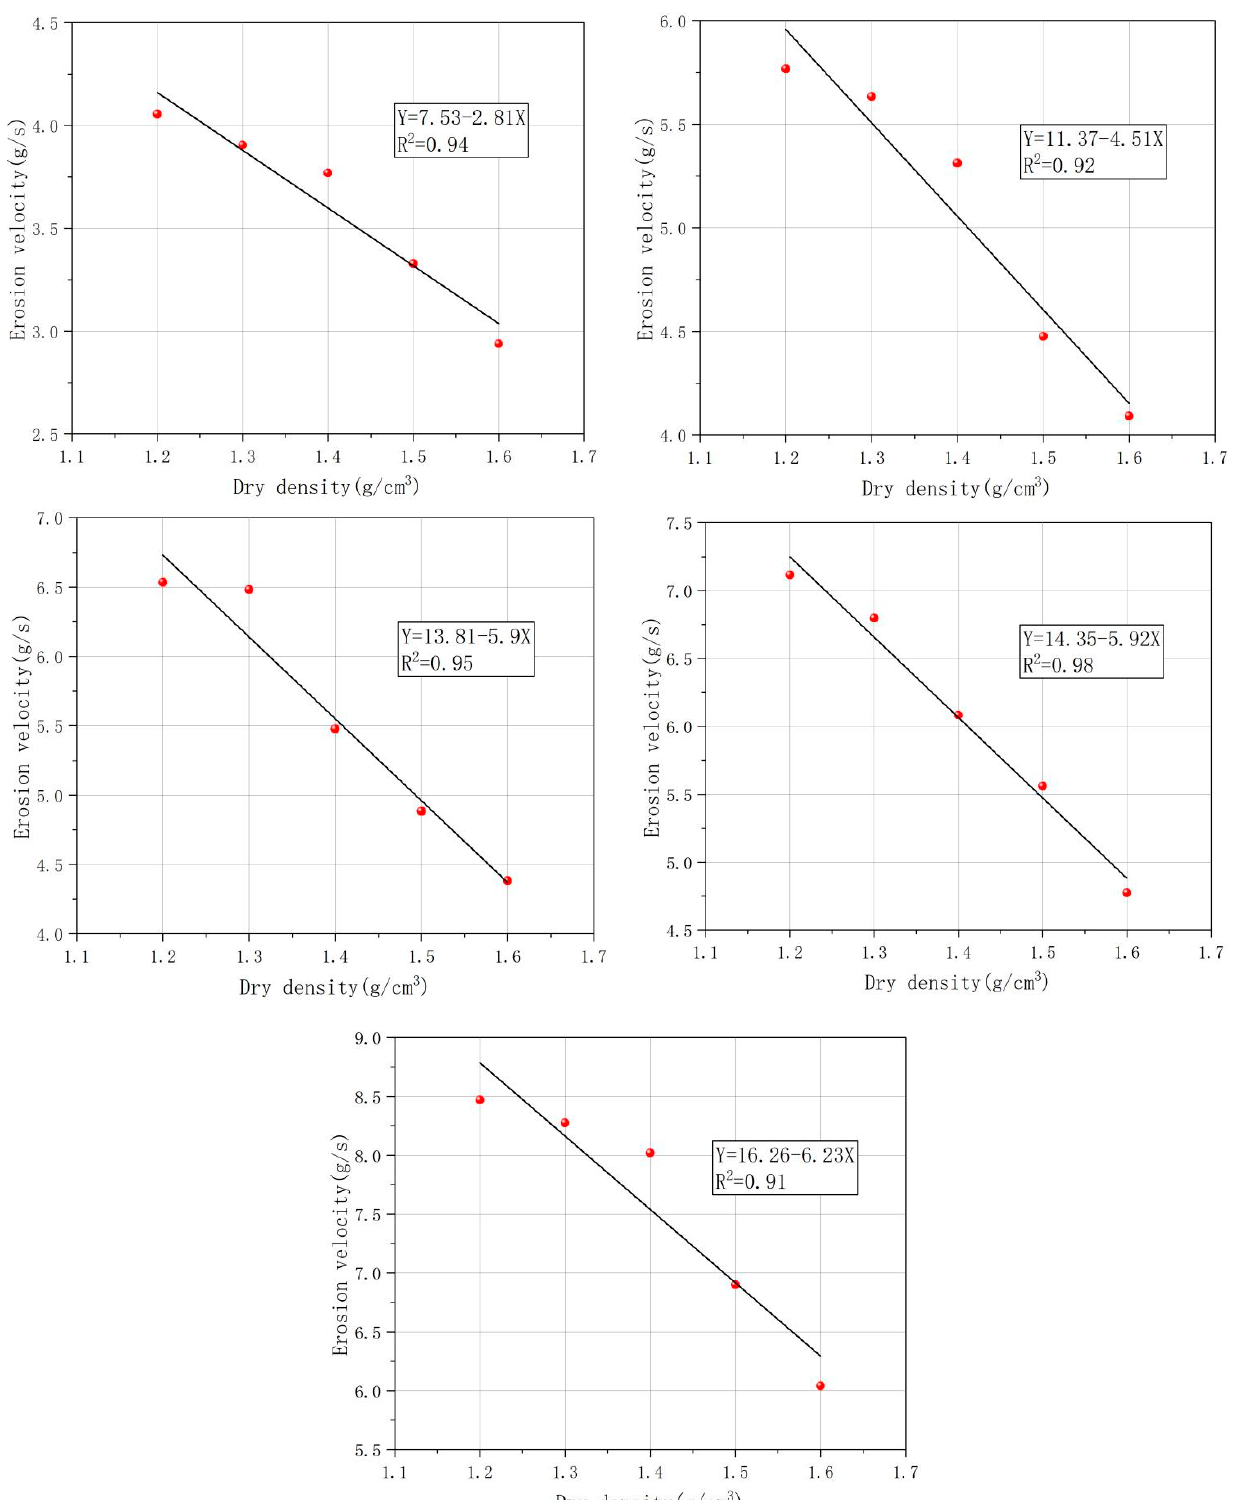
Figure 6. The relationship between loess erosion velocity and the initial dry density.